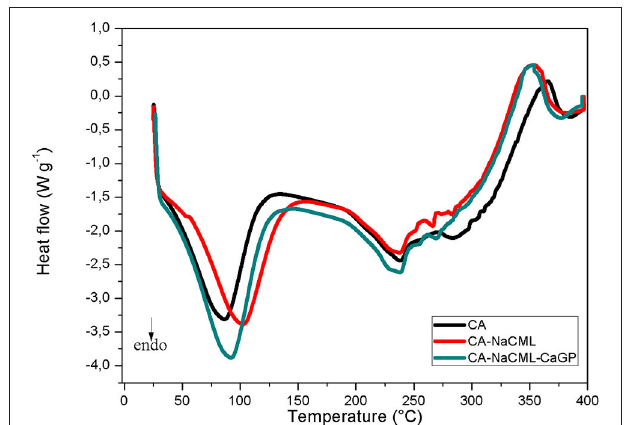
FIGURE 3 | XRD patterns of membranes.